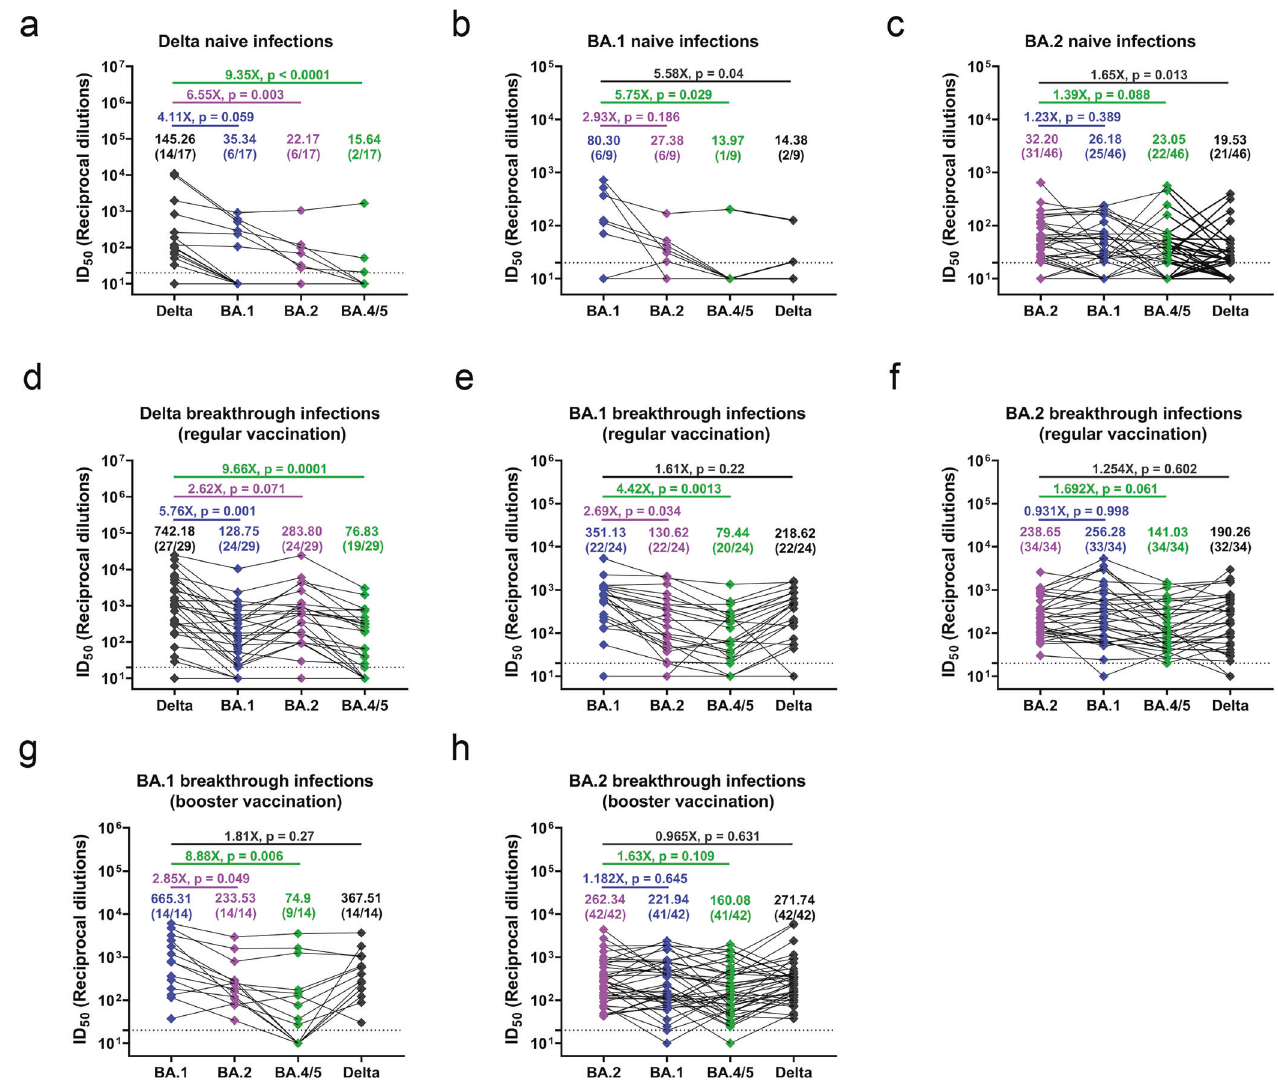
Fig. 1 Neutralizing pro fi les of naive and breakthrough infection with Delta, Omicron BA.1, and BA.2 variants. a – c ID 50 against Delta, BA.1, BA.2, and BA.4/5 variants of samples from naive infections with Delta ( a ), BA.1 ( b ), and BA.2 ( c ) variant. d – f ID 50 against Delta, BA.1, BA.2, and BA.4/5 variants of samples from breakthrough infections with Delta ( d ), BA.1 ( e ), and BA.2 ( f ) variant in regular vaccinees. g , h ID 50 against Delta, BA.1, BA.2, and BA.4/5 variants of samples from breakthrough infections with BA.1 ( g ) and BA.2 ( h ) variant in booster vaccinees. For all panels, values above the symbols denote geometric mean titers, and the numbers in parentheses denote the proportion of positive plasma with ID 50 above the limit of detection (dotted lines, ≥ 1:20). Values above the transverse lines denote fold changes and p values. Statistical signi fi cance was determined using Mann – Whitney U -test, and p values less than 0.05 were considered statistically signi fi